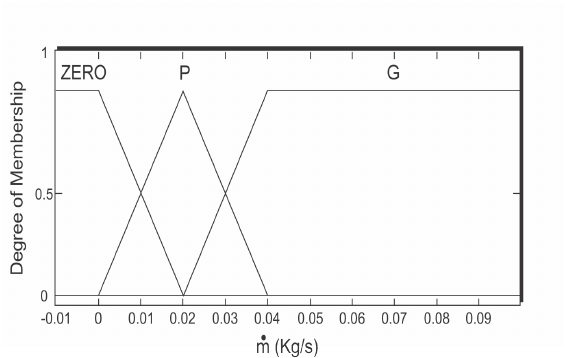
Figure 5. Output fuzzy set membership function for the flow reference in each collector. P, Positive; G,